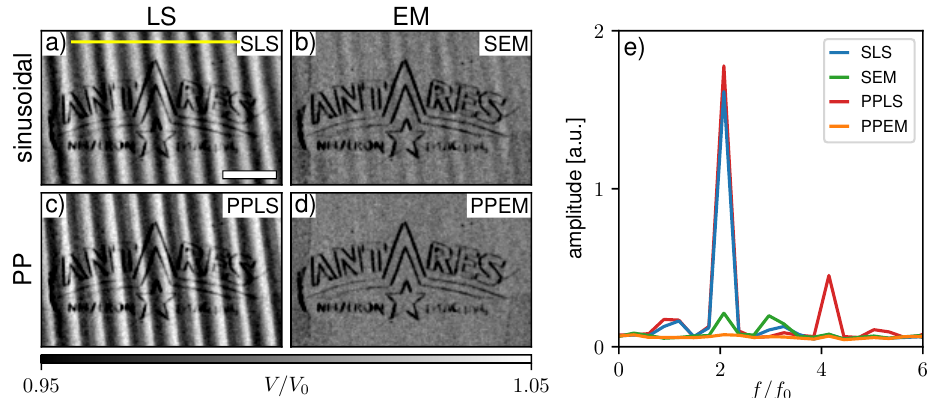
Figure 9. Dark-field images processed by ( a ) sinusoidal least square (SLS), ( b ) sinusoidal expectation maximization (SEM), ( c ) periodic polynomial least square (PPLS), and ( d ) periodic polynomial expectation maximization (PPEM) for the dataset measured at the Antares beamline. ( e ) Fourier spectra for the four algorithms averaged about 60 pixel lines along the yellow line in ( a ). The white scale bar in ( a ) represents